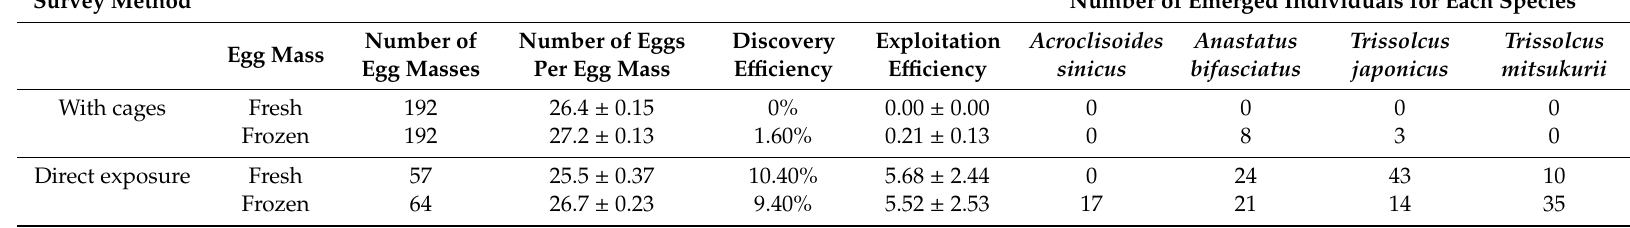
Table 3. Number of egg masses and mean number of eggs per egg mass used for the sentinel egg mass survey (with cages and direct exposure), showing the discovery e ffi ciency for each approach, the exploitation e ffi ciency (values followed by the same letter were not significantly di ff erent according to Kruskal-Wallis H Test), and the collected parasitoid